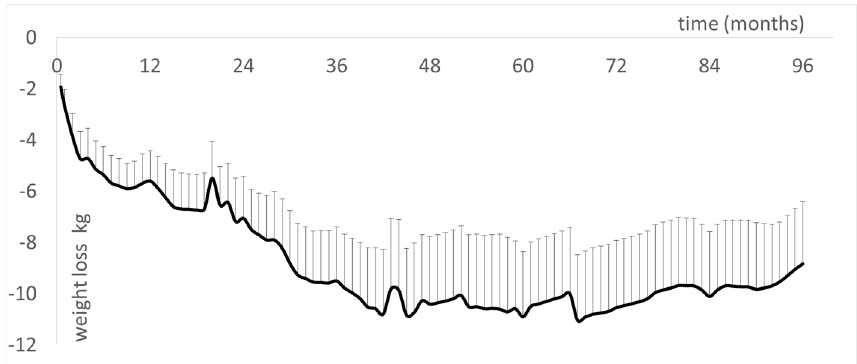
Figure 7. Follow-up of a cohort of 12 obese patients regularly followed over 96 months (results partially presented in [33] and further updated in January 2022). This is the continuation of previously presented shorter follow-up studies [17,18,231,256]. Results show that the weight-lowering effect of LIPOXmax training persists over more than 8 years.